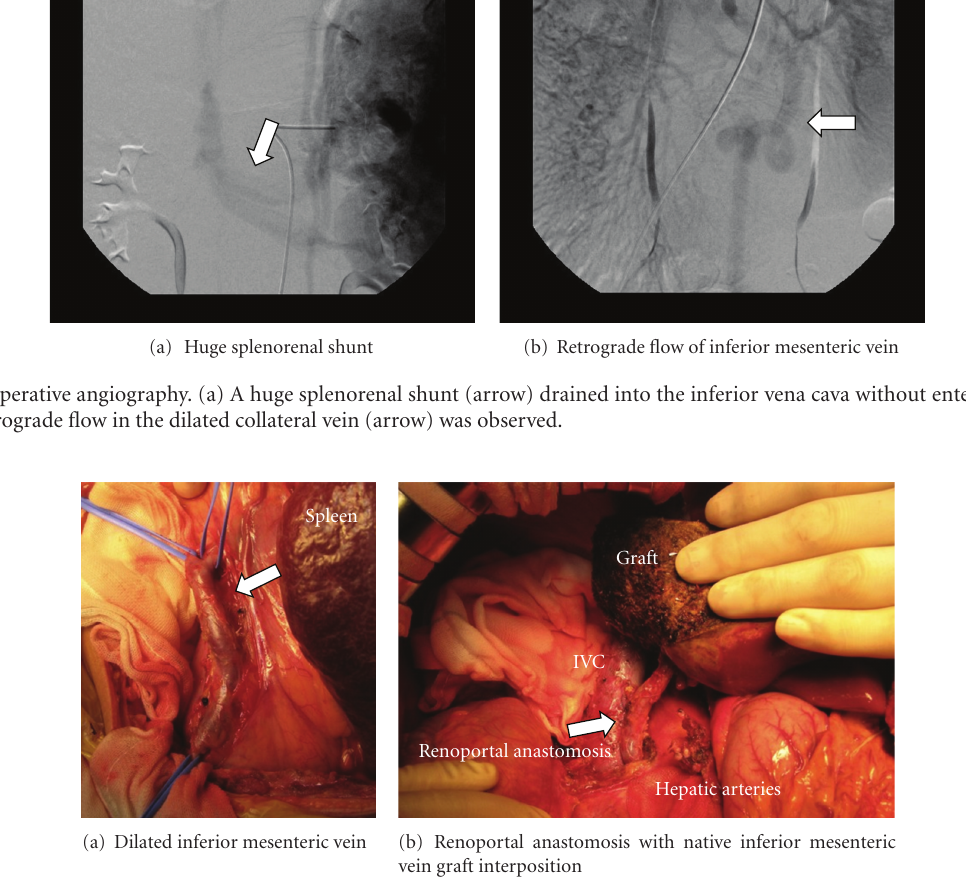
Figure 2: Renoportal anastomosis with the interpositional vein graft. (a) The intraoperative view shows the dilated collateral vein (arrow) procured as an interposition vein graft. (b) After the completion of the renoportal anastomosis with the vein graft